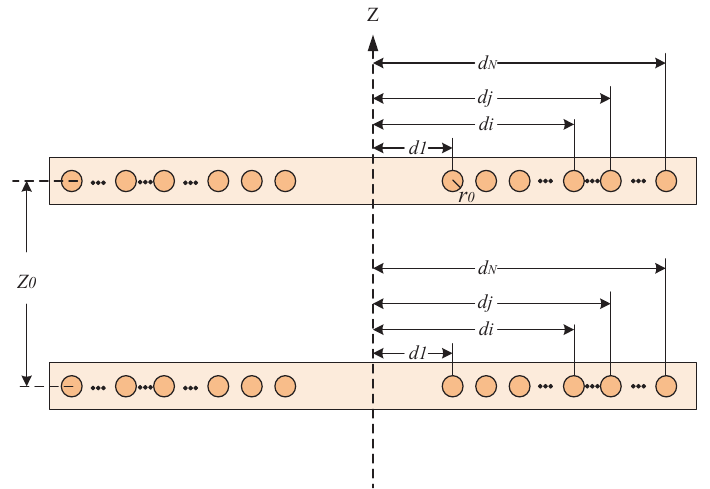
Figure 3. Two-dimensional axisymmetric model of planar circular